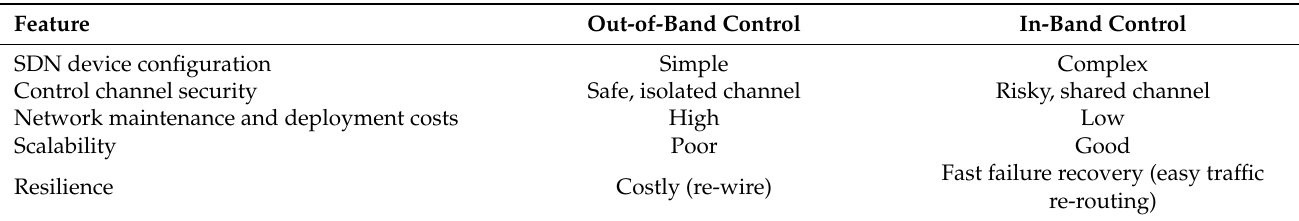
Table 1. Features of in-band and out-of-band